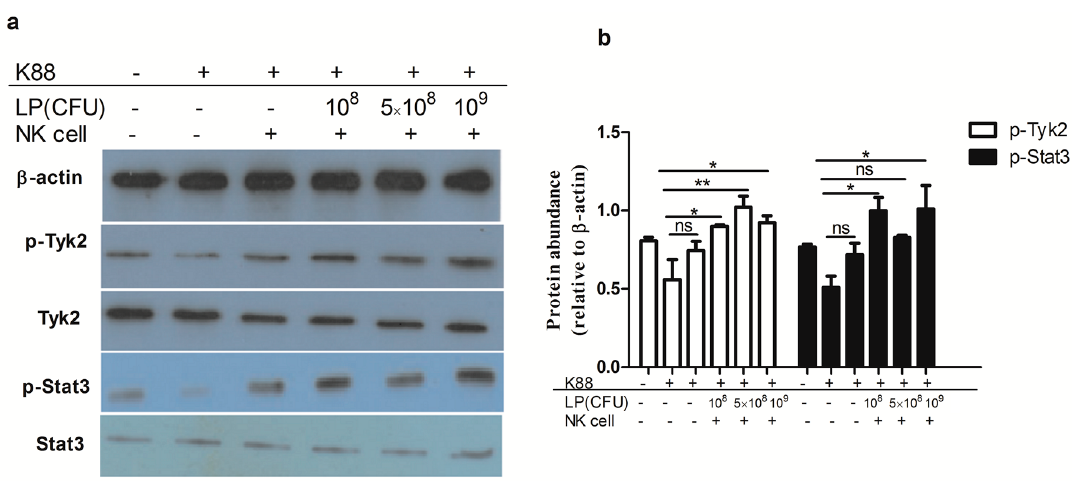
Figure 7. Lactobacillus plantarum (LP)-treated NK cells activated Tyk2 and Stat3 in NCM460 cells challenged with ETEC K88. NCM460 cell monolayers were untreated or treated with 10 8 CFU/ml ETEC K88 for 2 h, then NK cells stimulated by LP (0,10 8 , 5 × 10 8 or 10 9 CFU/mL) were added to ETEC K88-infected NCM460 cells and co-cultured for another 4 h. NCM460 cells were collected and protein abundances were analyzed. ( a ) Western blots showing the phosphorylation and total levels of Tyk2 and Stat3; ( b ) The ratios of p-Stat3 and p-Tyk2 to β -actin. Similar results were obtained from 3 independent experiments. Data are means ± SEM. * p < 0.05, ** p < 0.01, ns: not significant.